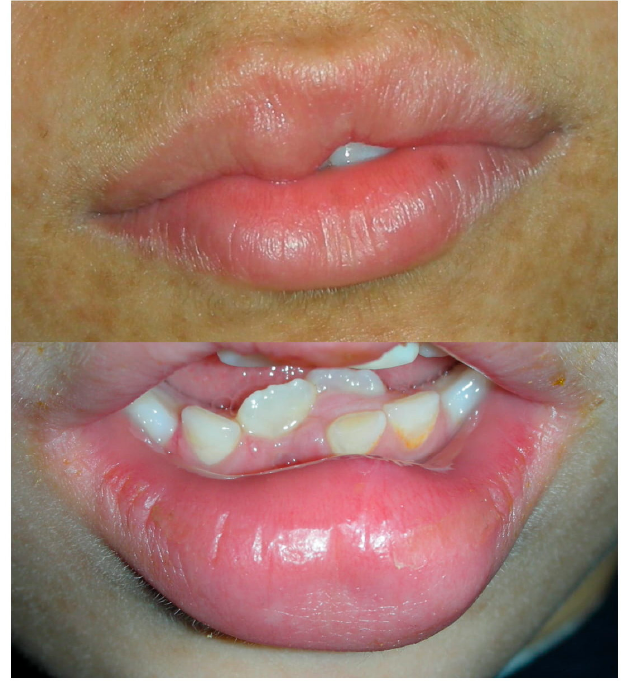
Figure 2. Multiple lips neurofibroma in NF I patient are showed.